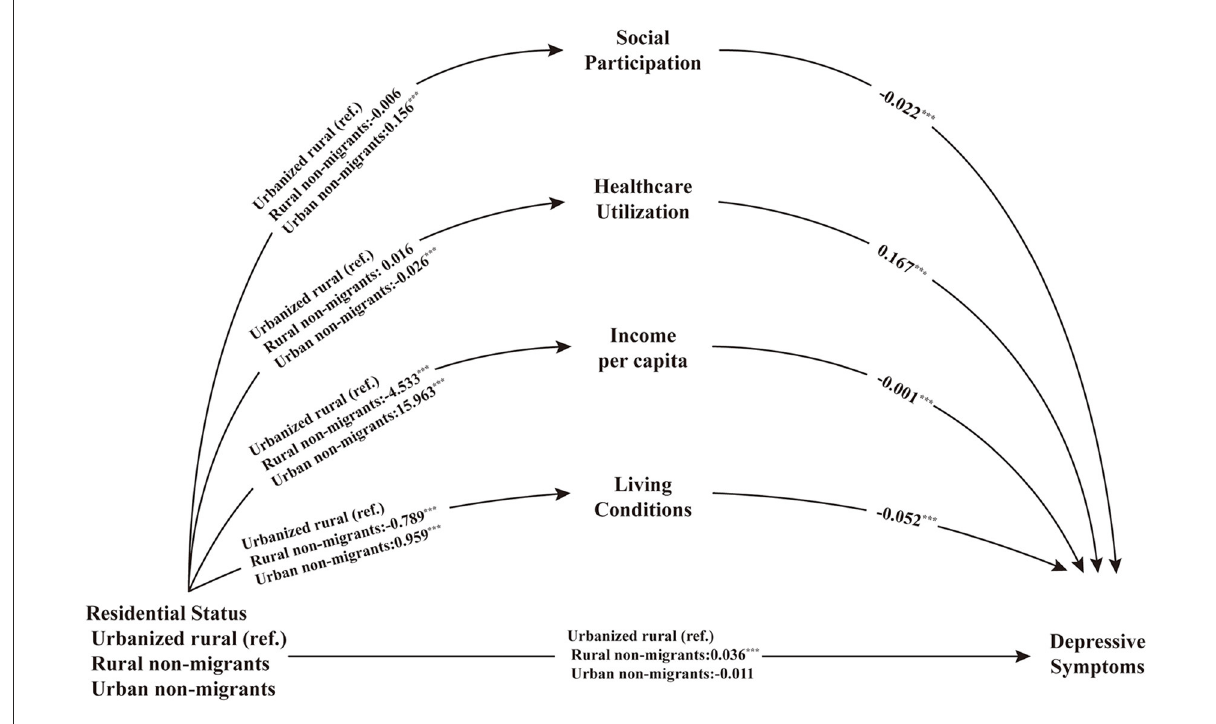
FIGURE3 Pathways between residential status and depressive symptoms. *** p < 0.001.